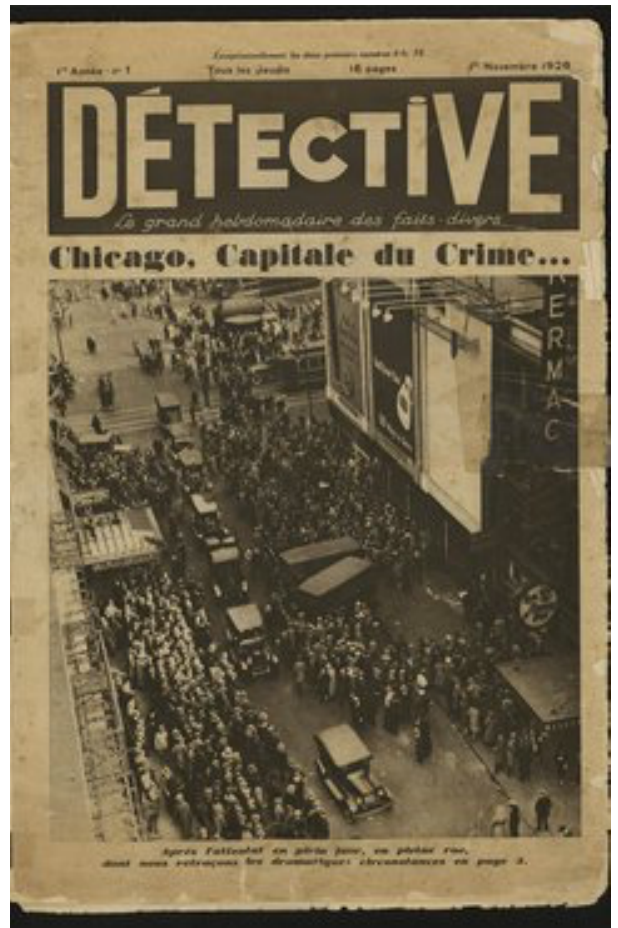
Fig. 1 Une de Détective , no. 1 (1 er novembre 1928), ©